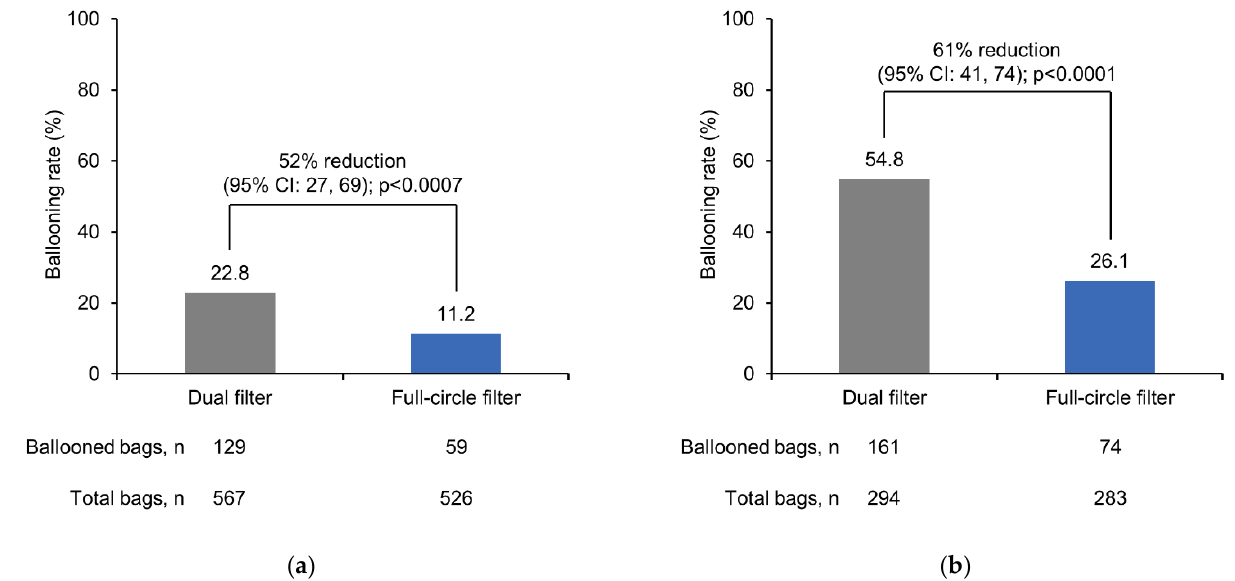
Figure 4. Frequency of ballooning with the full-circle filter versus the dual filter for ( a ) participants with a colostomy (n = 20), and ( b ) participants with an ileostomy (n = 20). Data are presented for the ITT analysis set. CI = confidence interval; ITT = intention-to-treat.